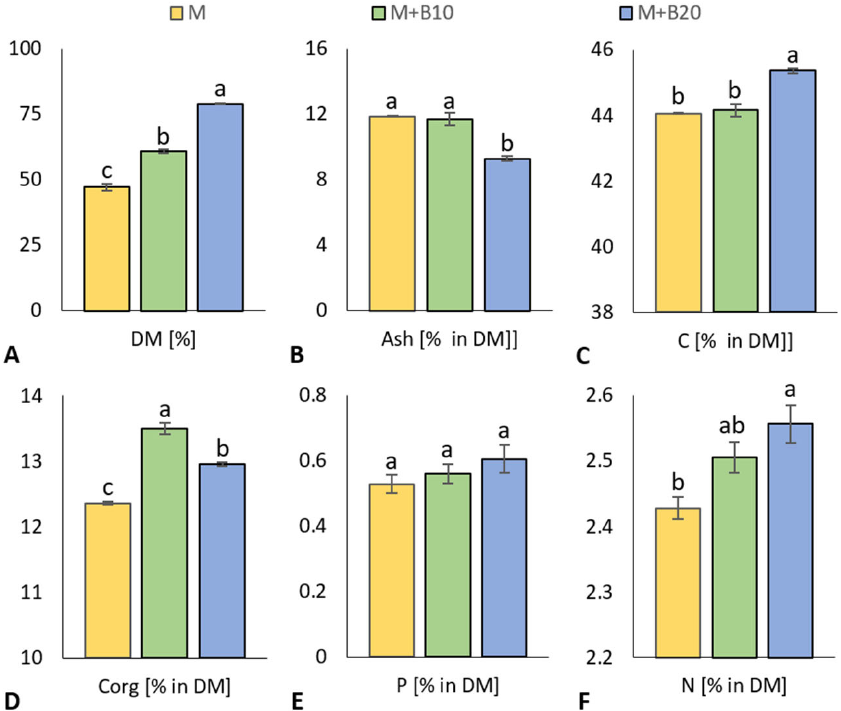
Figure 1. Dry matter ( A ), ash ( B ), total ( C ) and organic carbon ( D ), phosphorus ( E ), total nitrogen ( F ) in poultry litter treatments produced from untreated and biochar (10 and 20% w / w )-enriched litter. Displayed are mean values with error bars (standard error of mean); letters indicate differences between values at the statistical level of significance p ≤ 0.05.